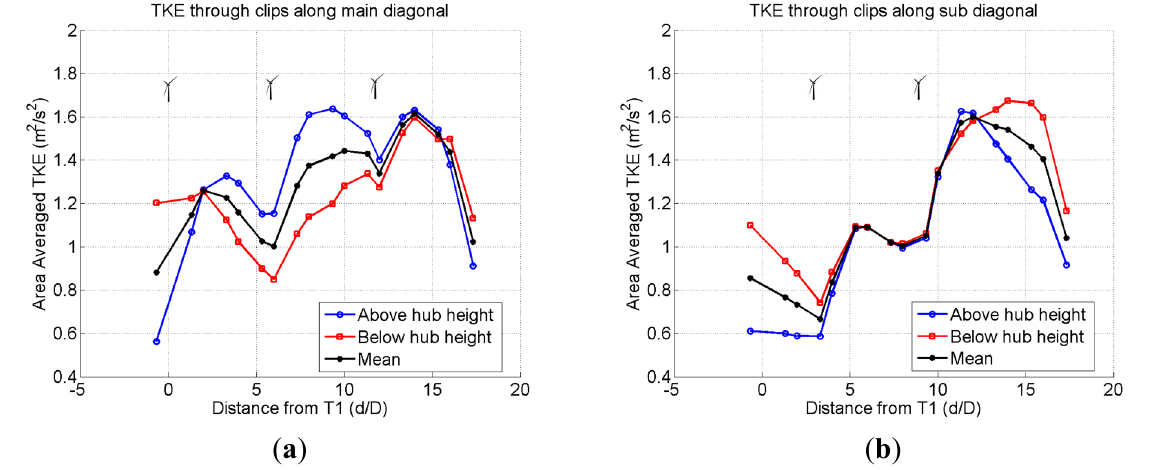
Figure 24. Averaged TKE across clipped wake surface cutting planes above/below hub